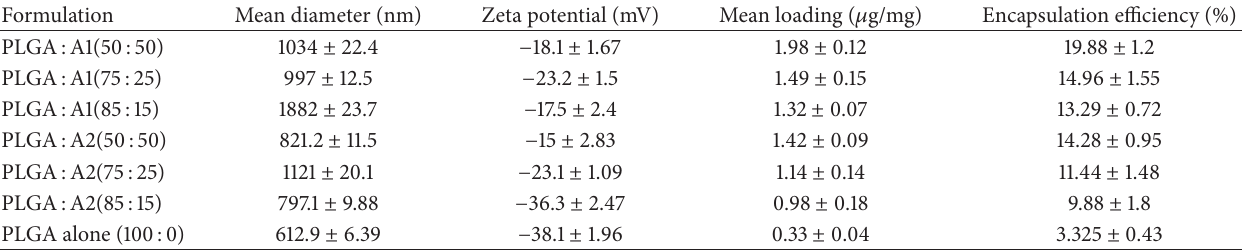
Table 1: Characterization of microparticles with respect to mean diameter, zeta potential, mean loading, and encapsulation efficiency.